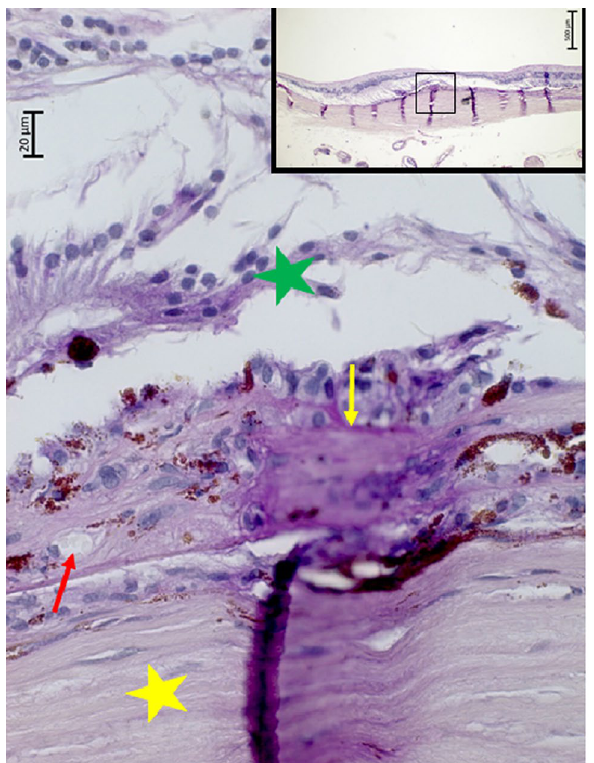
Figure 2. Histophotograph showing a neovascular myopic macular degeneration with irregular proliferations of irregularly pigmented retinal pigment epithelium cells, connected with a PAS (Periodic-Acid-Shiff)-positive, crumbled basal membrane (yellow arrow), retinal capillaries (red arrow), and fibrous tissue, located beneath a disarranged retina (green asterisks); yellow asterisks: